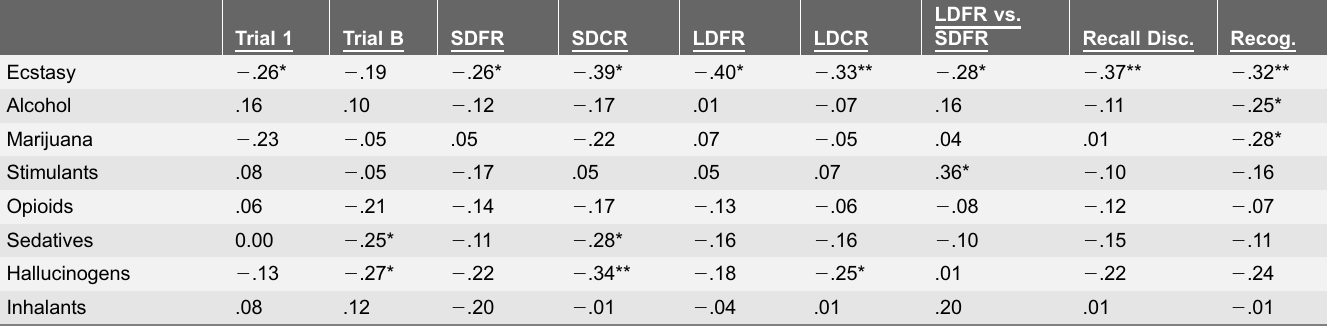
Table 4. Simple Relationships between Components of Verbal Memory and Drug Usage Variables (Past